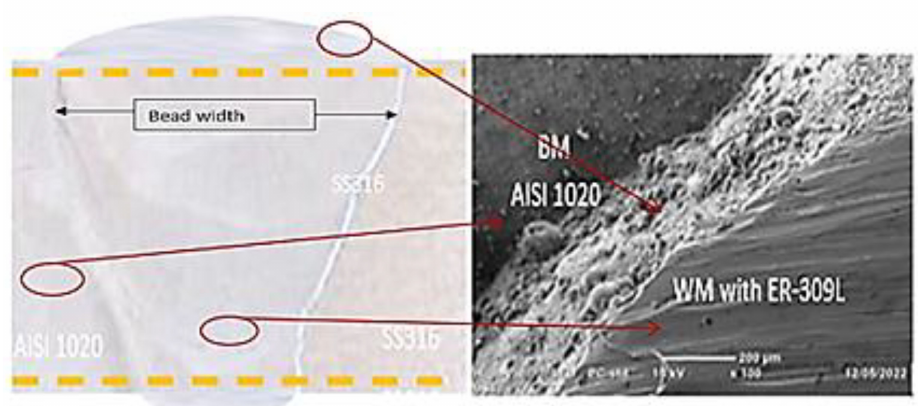
Figure 16. Weld bead of welded metals specimens welded image with ER-309L.